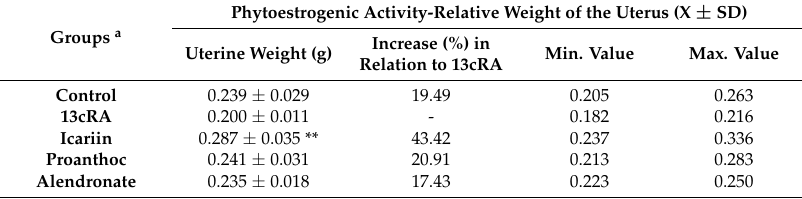
Table 8. Effect of icariin, proanthocyanidins and alendronate on relative uterine weight and relative bone weight in rats with retinoic acid-induced bone